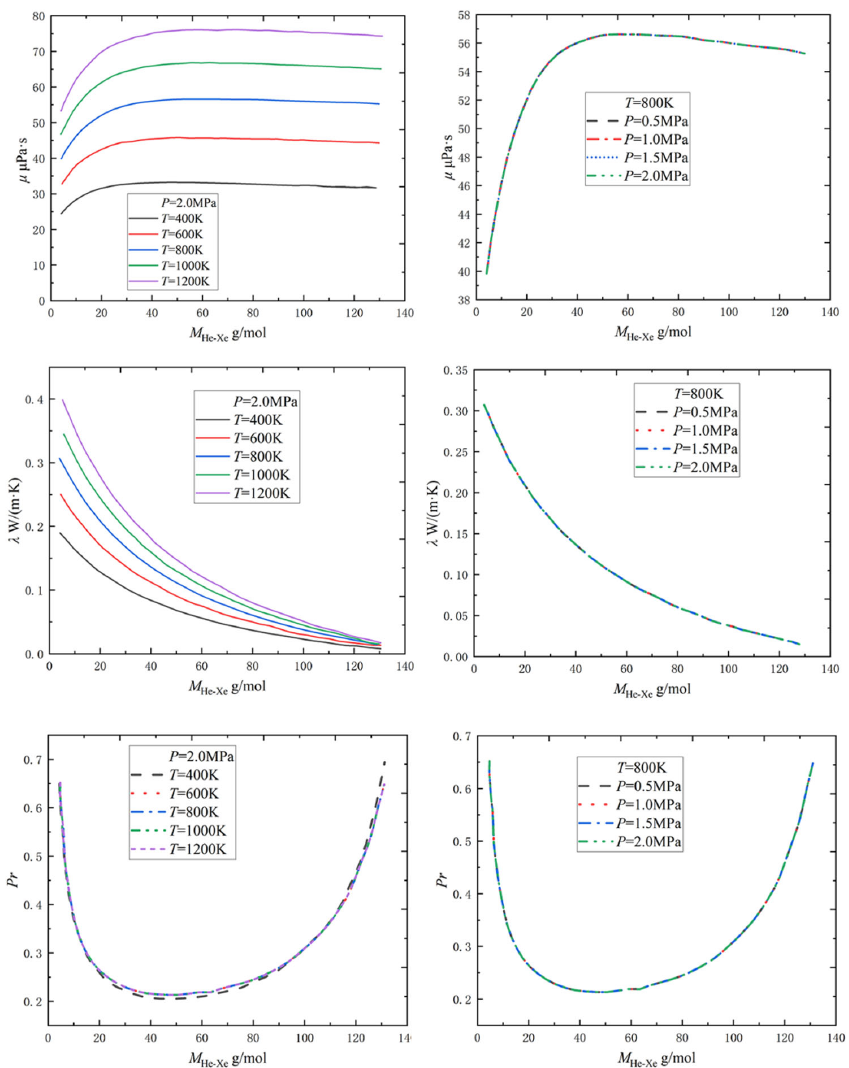
Figure 3. Variation of transport properties of helium–xenon gas mixture with molar mass of helium– xenon gas mixture [1,8].